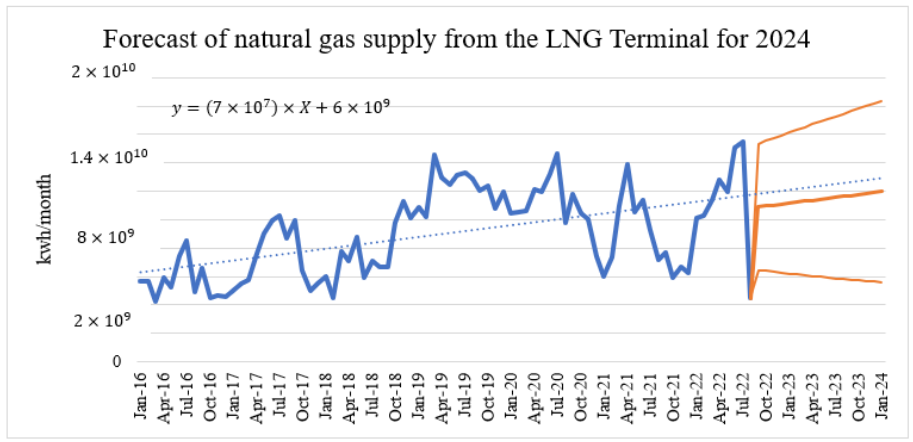
Figure 2. Forecast of natural gas supply from LNG Terminal for 2024. These data can be found here: https://www.ec.europa.eu/ (accessed on 20 March 2022).